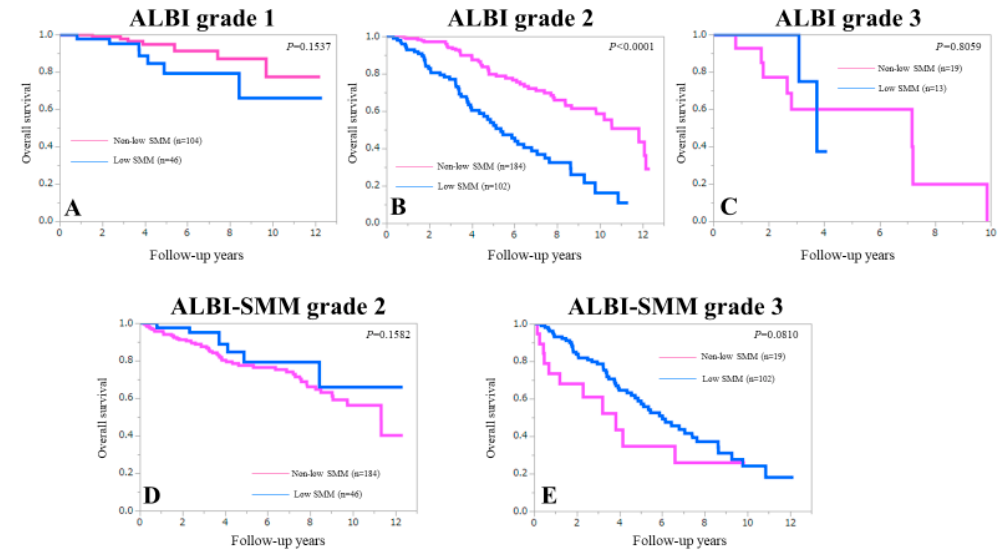
Figure 1. Kaplan-Meier curves in patients with low SMM ( n = 161) and without low SMM ( n = 307). The 3-, 5-, 7- and 10-year cumulative overall survival rates were: 79.5%, 60.3%, 49.5% and 31.8% in the low SMM group, and 89.4%, 80.6%, 76.5% and 59.7% in the non-low SMM group ( P < 0.0001).